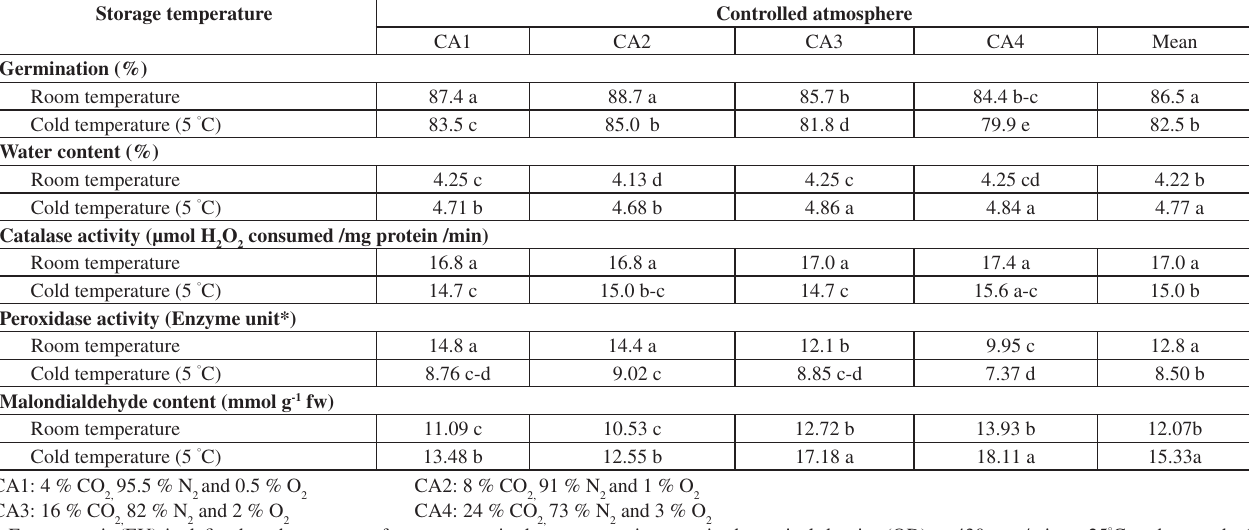
Table 1: Effect of storage temperature, controlled atmosphere and their interactions on germination (%), water content (%), catalase and peroxidase activity, and malondialdehyde content of onion seeds stored for 12